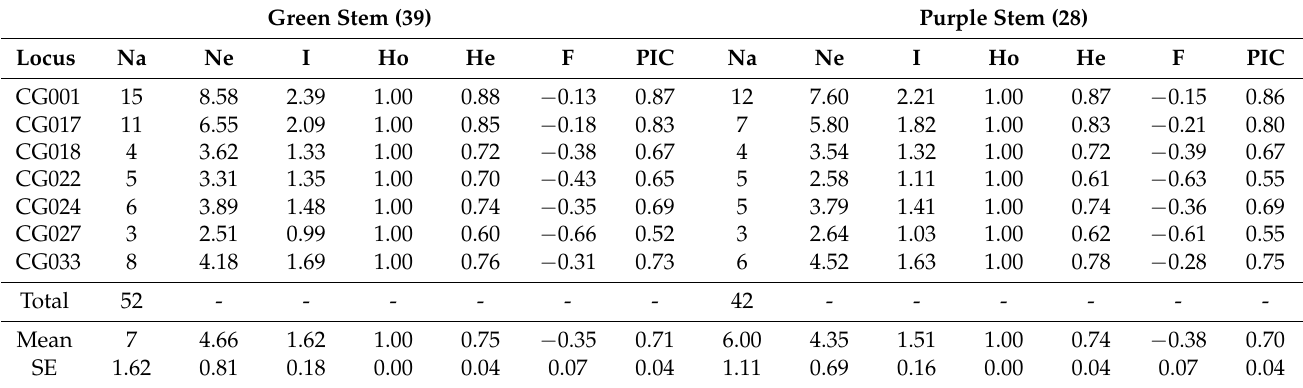
A total of 52 alleles were generated by SSR markers in accessions with a green stem with an average of 7 alleles per locus and 42 alleles in accessions with a purple stem, with an average of 6 alleles per locus (Table 10). The number of effective alleles ranged from 2.51 for marker CG027 to 8.58 for marker CG001 in accessions with green stems, while in those with purple stems the number of effective alleles ranged from 2.58 (CG022) to 7.60 (CG001). Shannon’s Information Index ranged from 0.99 (CG027) to 2.39 (CG001) in phenotypes with a green stem. The expected heterozygosity revealed by the SSR marker ranged from 0.60 to 0.88 for accessions with a green stem, with an average of 0.75, while the PIC value averaged at 0.71 (Table 10). Table 10. Genetic diversity parameters generated by SSR markers between green and purple stem accessions. Green Stem